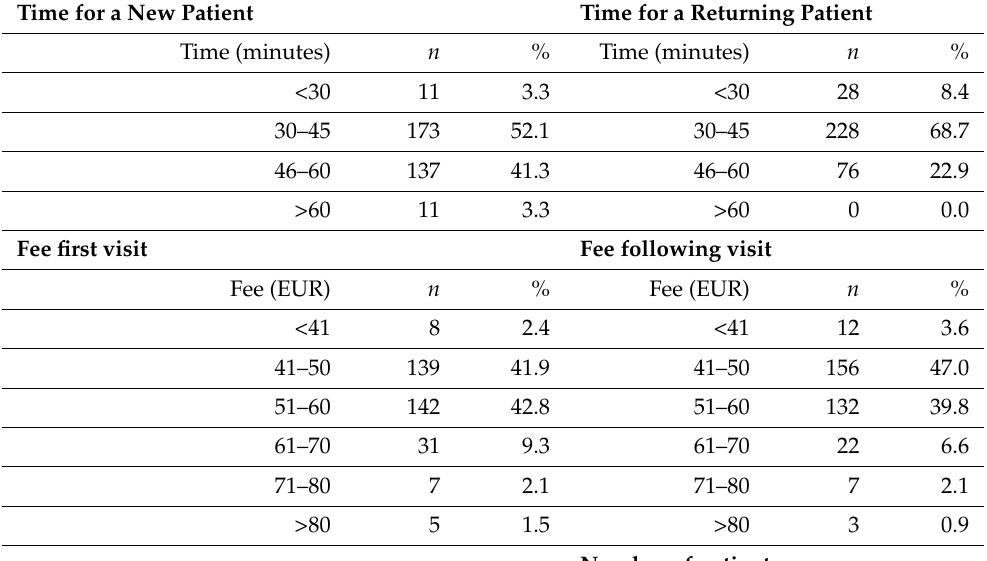
Table 3. Distribution of participants’ consultation features ( n =